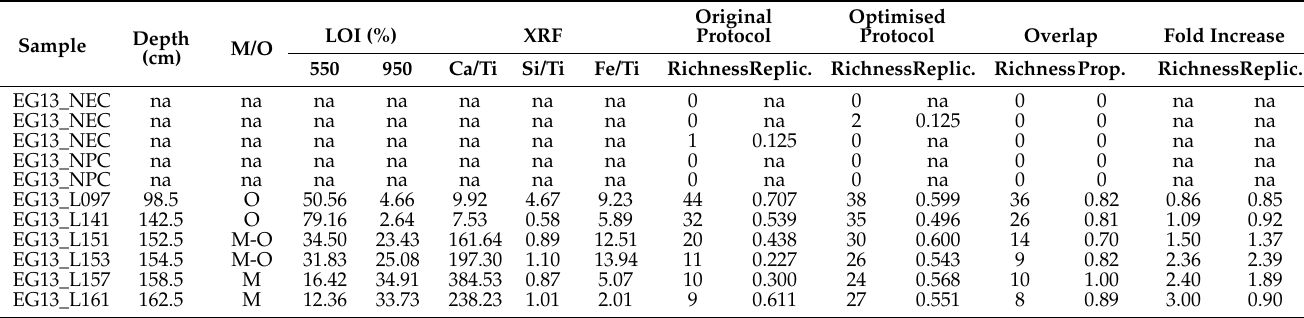
Table A10. Metadata for the six tested sediment samples and five negative controls. M: minerogenic-rich; O: organic-rich; M-O: minerogenic-organic. Sample